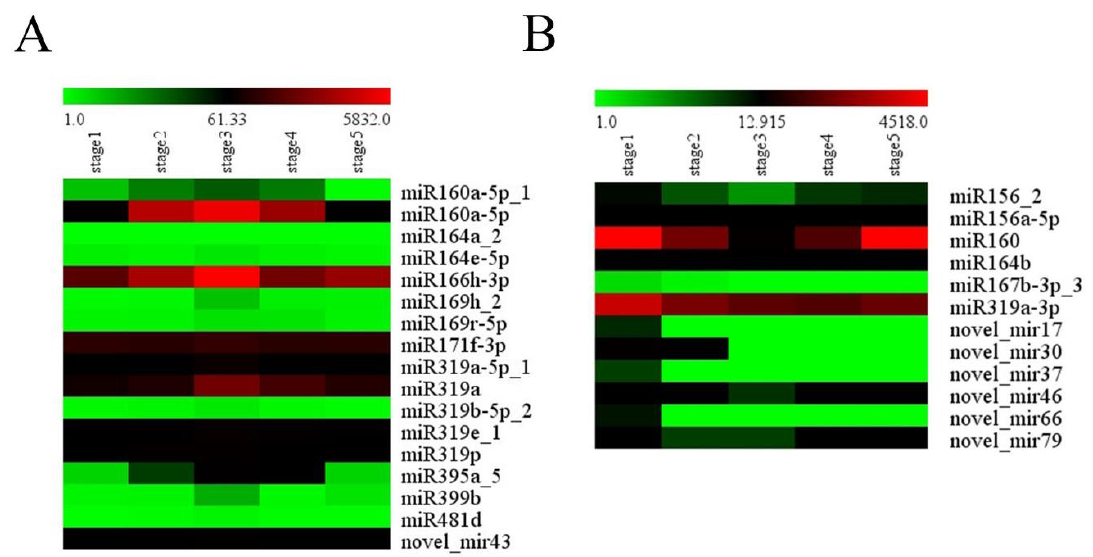
Figure 4. Heat map of miRNA expression in cluster 7 and cluster 8. ( A ) The expression pattern of miRNA in cluster 7. ( B ) The expression pattern of miRNA in cluster 8.